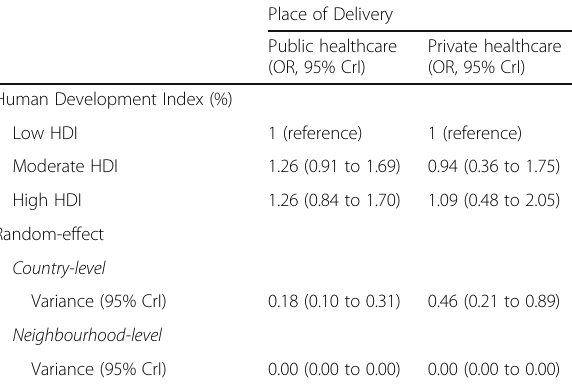
Table 3 Individual compositional and contextual factors associated with Caesarean section in sub-Saharan Africa identified by multivariable multilevel logistic regression models, Demographic and Health Surveys data